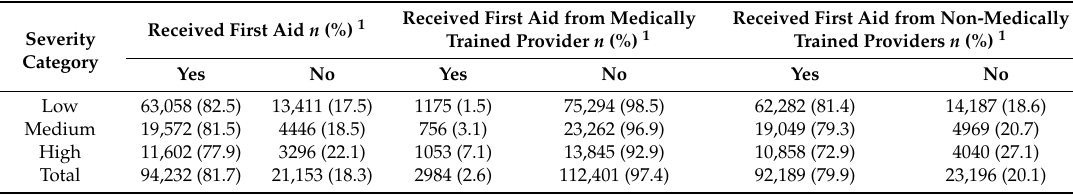
Table 3. Percentage of non-fatal injury events that received first-aid according to injury severity categories,